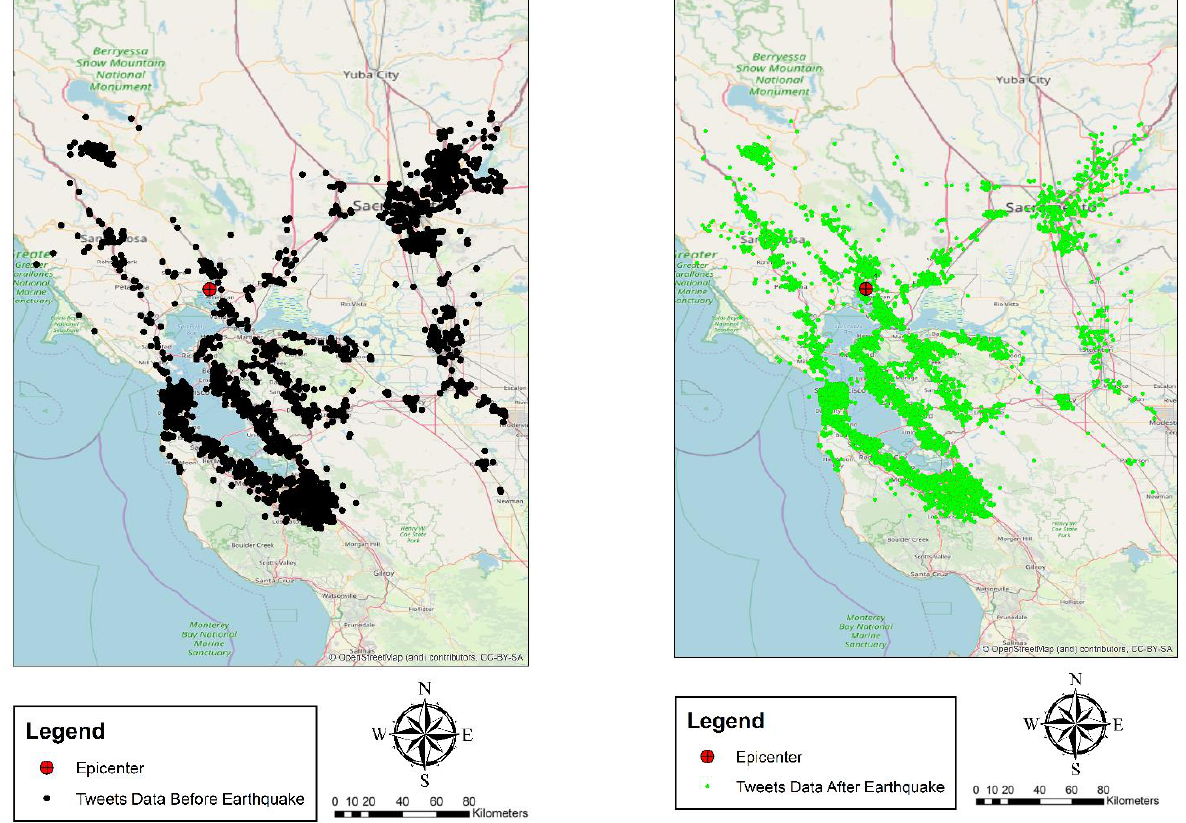
Figure 1. Description of Napa earthquake study area with tweet locations 7 days before the earthquake ( left ) and 7 days after the earthquake ( right ).